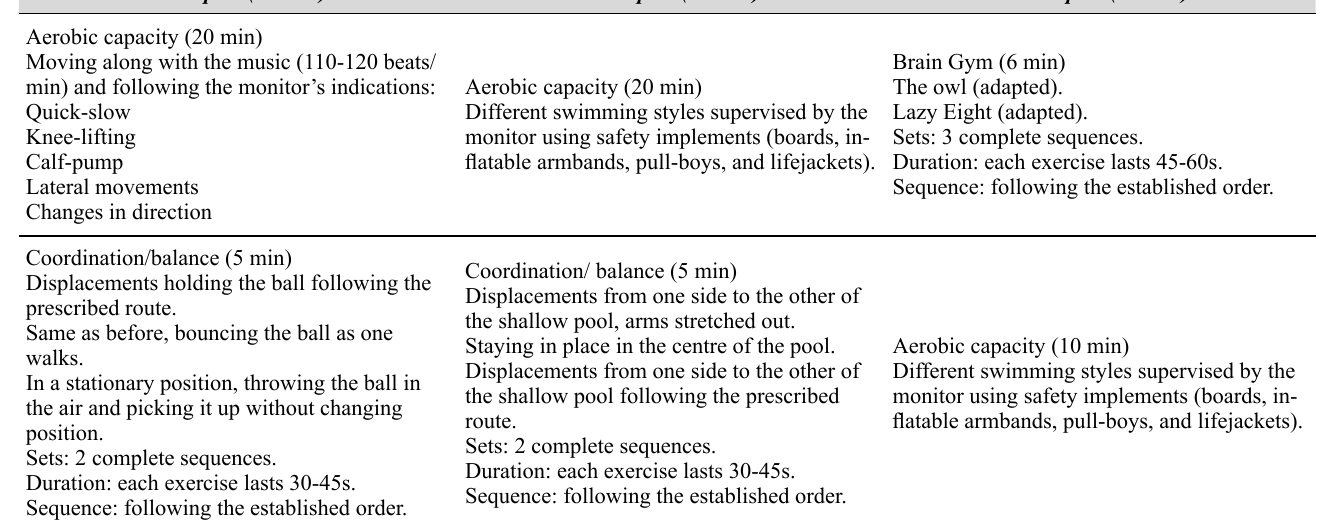
Table 1. Exercise interventions. Land-based exercise Water-based exercise Callisthenic Callisthenic Brain gym Warm-up exercises (10 min) Warm-up exercises (15 min) Warm-up exercises (15 min) Aerobic work (5 min) Walking in different directions, following the monitor’s instructions.